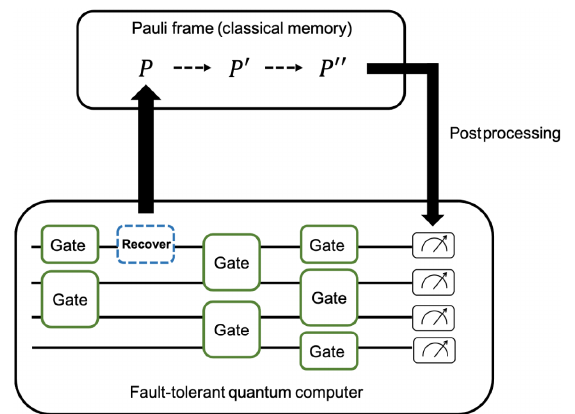
FIG. 2. Schematic figure of the Pauli frame. The recovery operations are not physically applied to quantum computers but rather are stored in the Pauli frame and efficiently updated after each Clifford gate operation. The measurement outcomes are flipped depending on the state of the Pauli